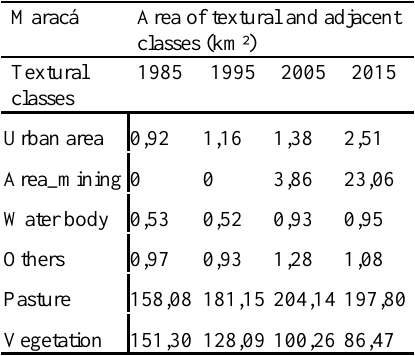
Table 2. Information classes and their respective adjacent areas (km²) of the mining company Maracá from 1985 to 2015.